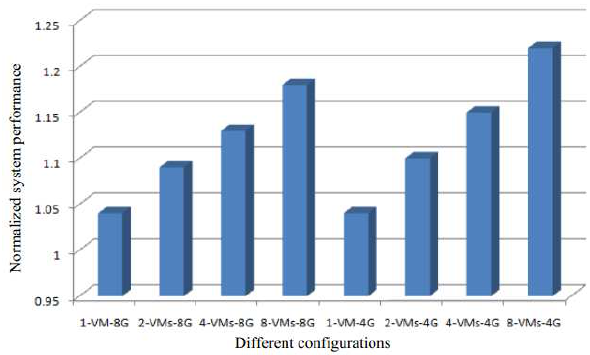
Figure 7. The normalized performance improvement when running same operating system for simultaneously VMs.